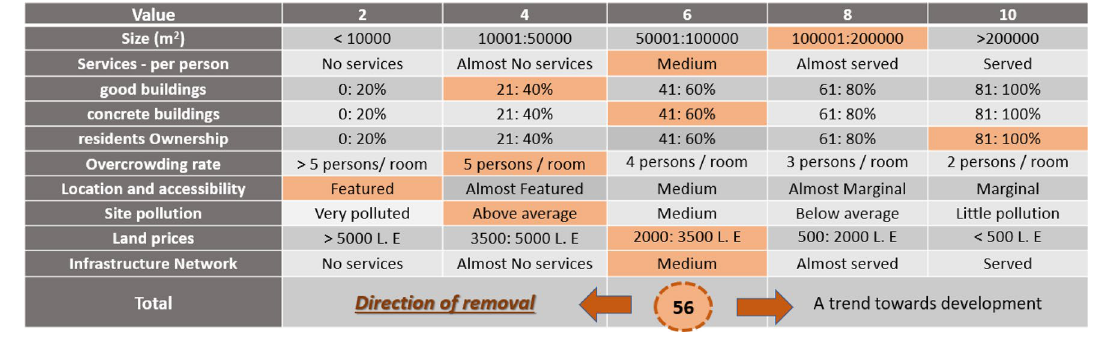
Table 6 Ezbet El‑Shahatin Matrix defining the intervention policy (Source: Adapted researcher “Tools and Methods of Dealing with